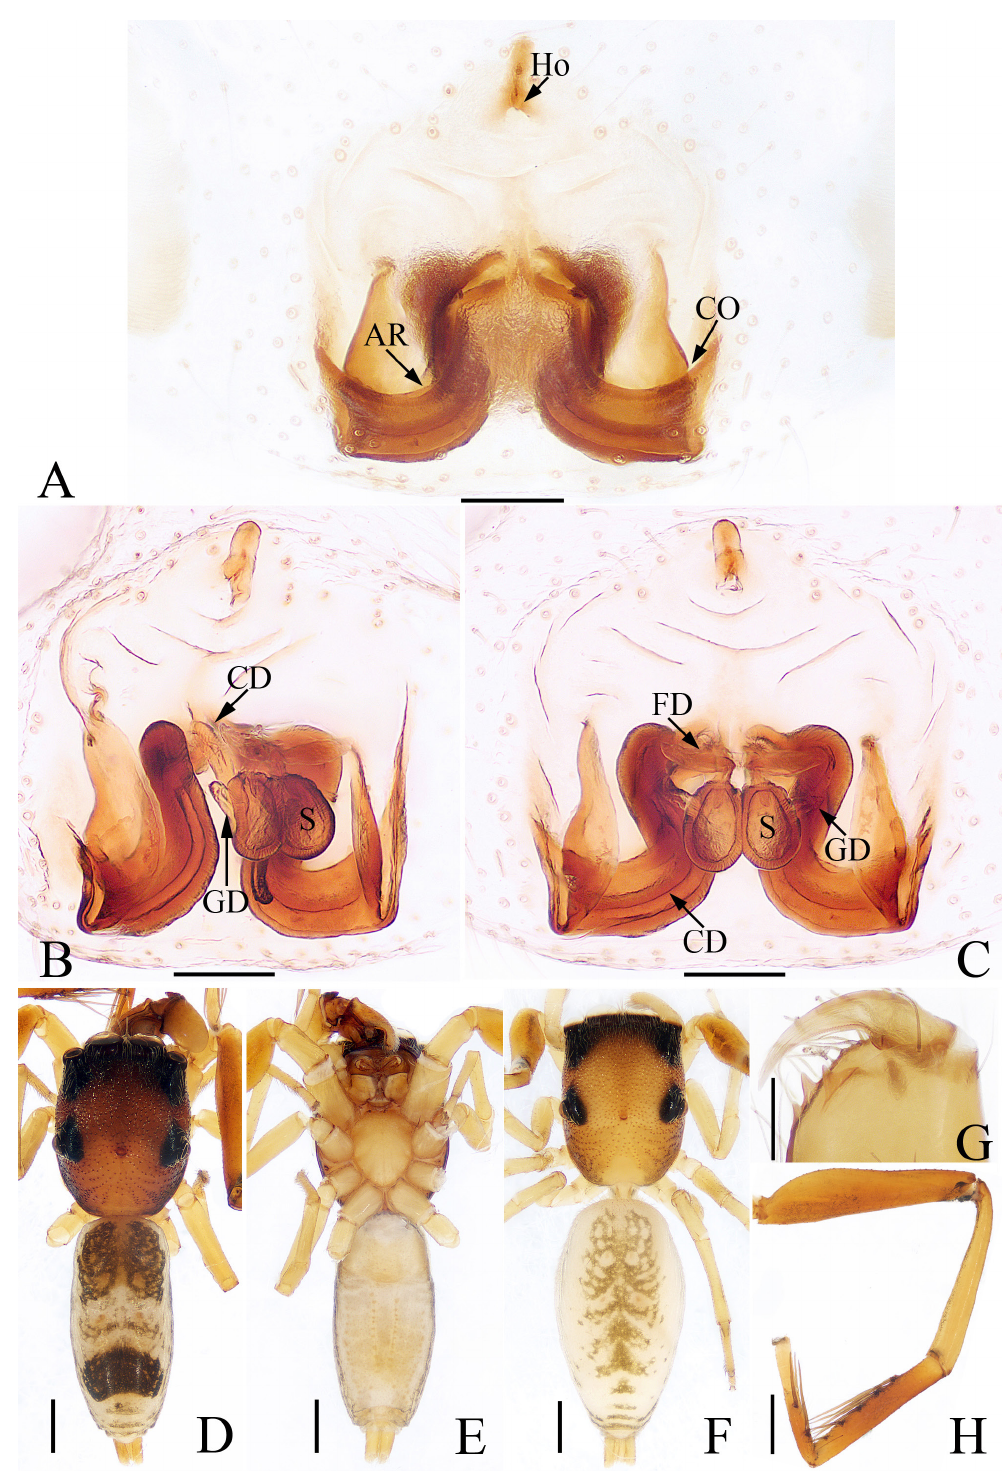
Fig. 14. Synagelides wuliangensis sp. nov. A–C, F . Paratype, ♀ (TRU-Salticid-0050). D–E, G–H . Holotype, ♂ (TRU-Salticid-0044). A . Epigyne, ventral view. B . Epigyne, dorsolateral view. C . Epigyne, dorsal view. D . Habitus, dorsal view. E . Habitus, ventral view. F . Habitus, dorsal view. G . Chelicerae, dorsal view. H . Leg I, prolateral view. Abbreviations: see Material and methods. Scale bars: A–C, G = 0.1 mm; D–F, H = 0.5